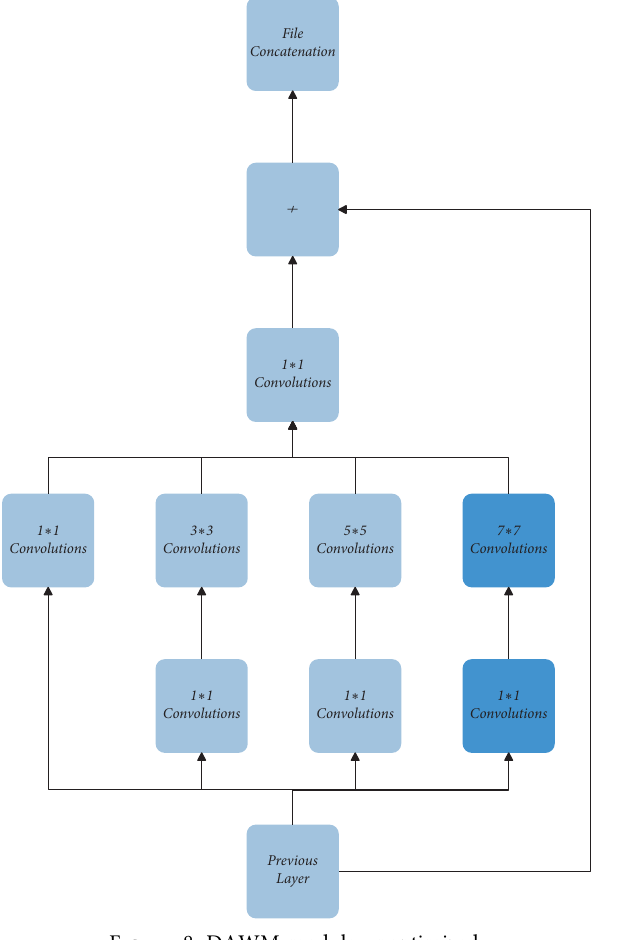
Figure 8: DAWM module unoptimized.